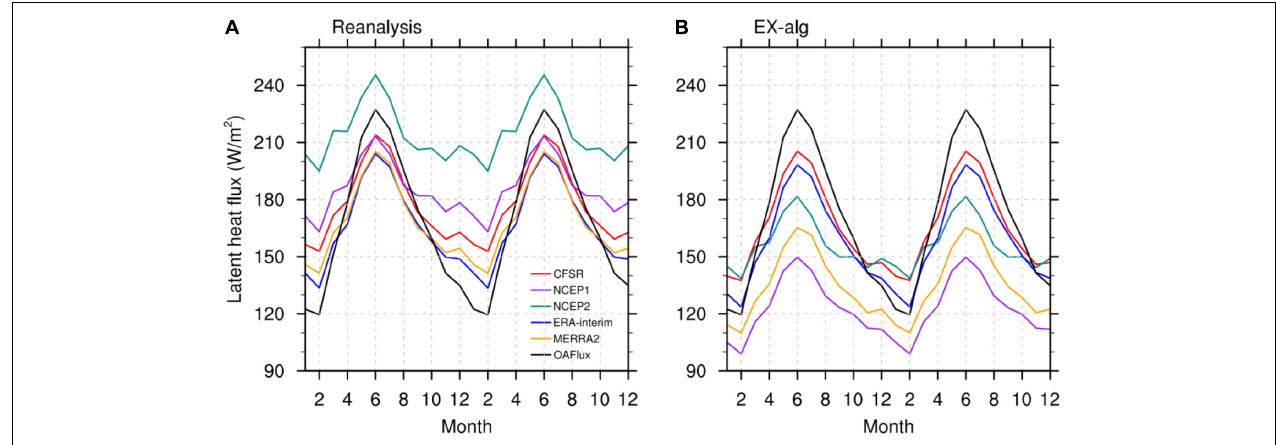
FIGURE 1 | Climatological seasonal cycle of latent heat flux calculated for the area around the west coast of Australia (110 ◦ E-116 ◦ E, 22 ◦ S-32 ◦ S) from (A) reanalysis products, (B) sensitivity calculations using COARE3.5 algorithm (EX-alg). Positive values indicate the flux from the ocean to the atmosphere.